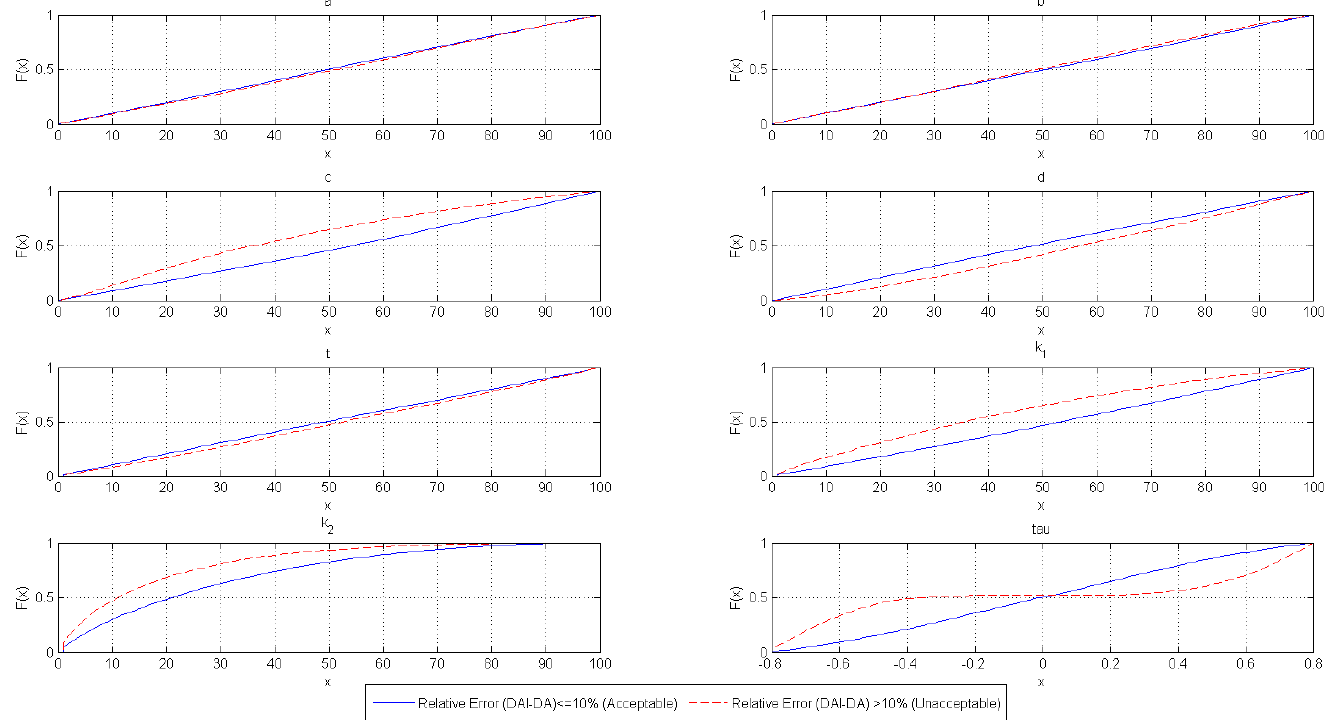
Figure 2. Observed CDF of individual parameters in DAI − DA